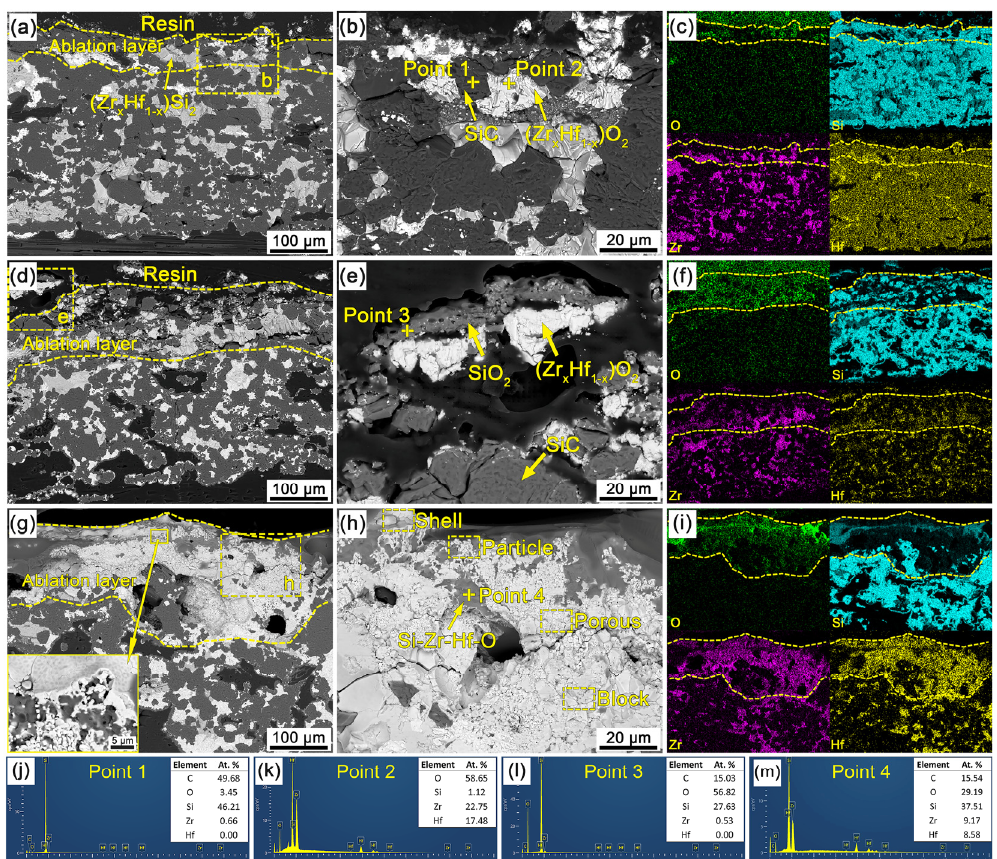
Figure 9. Cross-section SEM micrographs and EDS results of the C/C-SiC-(Zr x Hf 1 − x )C composites in the central region after ablation: ( a – c ) CMC-1; ( d – f ) CMC-2; ( g – i ) CMC-3; ( j – m ) EDS results.